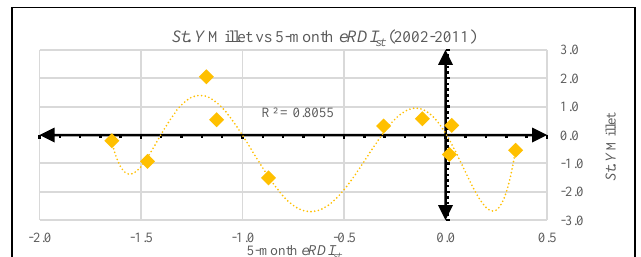
Figure 7: St. Y Millet vs 5-month eRDIst Table 5: R 2 values between standardised crop yields and the 5-month eRDI st R 2